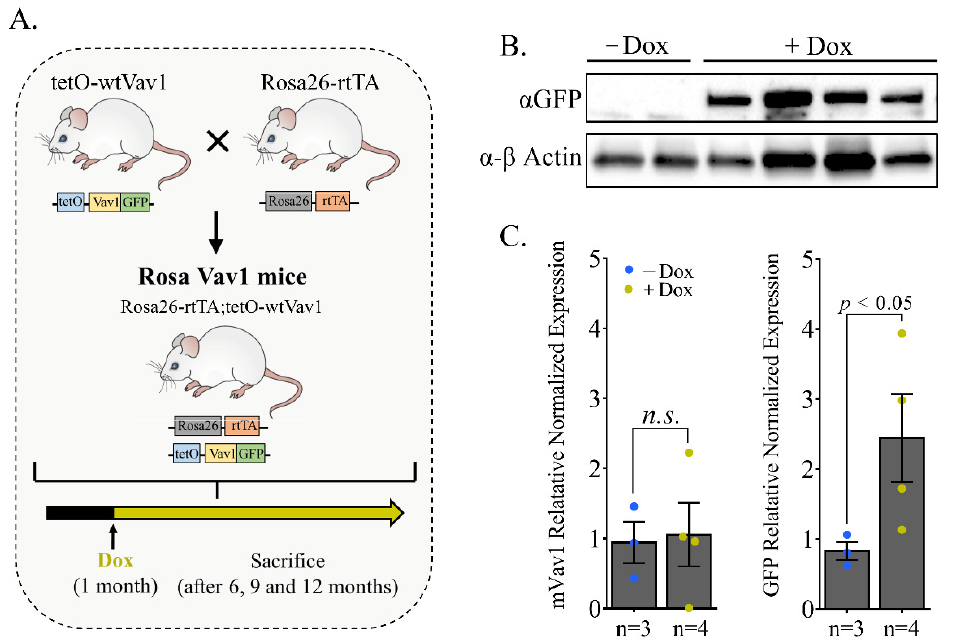
Figure 1. RosaVav1 transgenic mouse model ( A ) and expression pattern ( B ). ( A ) Schematic diagram of breeding strategy to generate RosaVav1 transgenic mice. Rosa26-rtTA mice were crossed with tetO-wtVav1 mice to generate Rosa26-rtTA/tetO-wtVav1 mice (Rosa Vav1 mice). To induce Vav1 expression, mice were treated with Dox one month after birth. Mice were sacrificed at different time points (6, 9, and 12 months after transgene induction). ( B ) Expression of transgenic Vav1 protein in the lungs of Rosa Vav1 mice. Western blotting using anti–GFP (indicative of the transgene human ‐ Vav1 expression) and anti ‐ Actin Abs. ( C ) Expression of transgenic human Vav1 mRNA (GFP) and murine Vav1 (mVAV1) in the lungs of Rosa Vav1 mice. Quantitative real-time PCR analysis showing the mean mRNA expression of murine Vav1 (mVav1; left panel) and GFP (human transgenic Vav1; right panel) in lung tissues from Rosa Vav1 mice either treated (+Dox; n = 4) or non-treated ( − Dox; n = 3), 12 months post transgene induction is depicted. SEM and significance between the treated (+Dox) and the non ‐ treated ( − Dox) analyzed by t ‐ test are indicated. n.s. means non ‐ signifi ‐ cant.